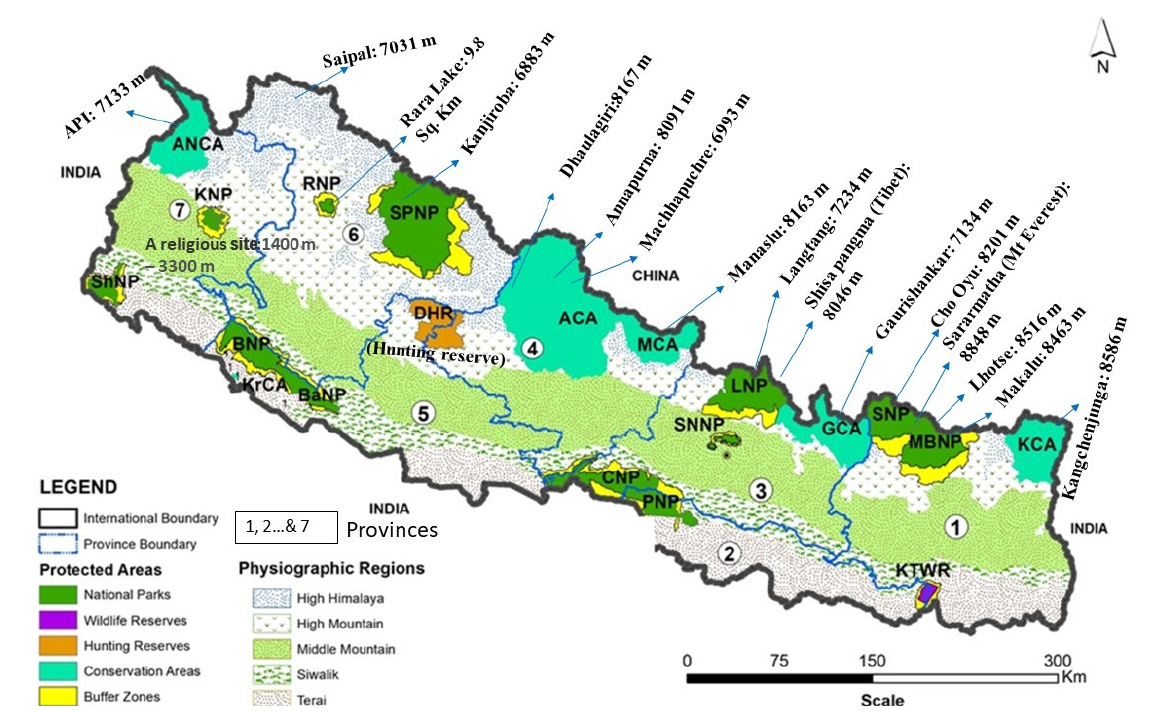
Figure 4. Protected areas are established mostly in the areas with the highest mountains [Source: Department of Wildlife Conservation